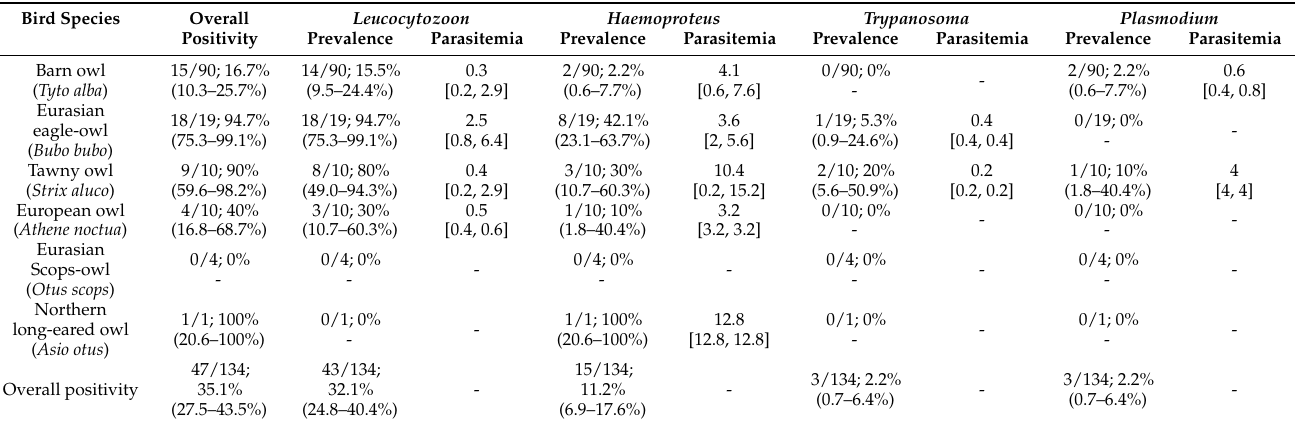
Table 1. Prevalence and parasitemia of blood parasite genera detected among the owl